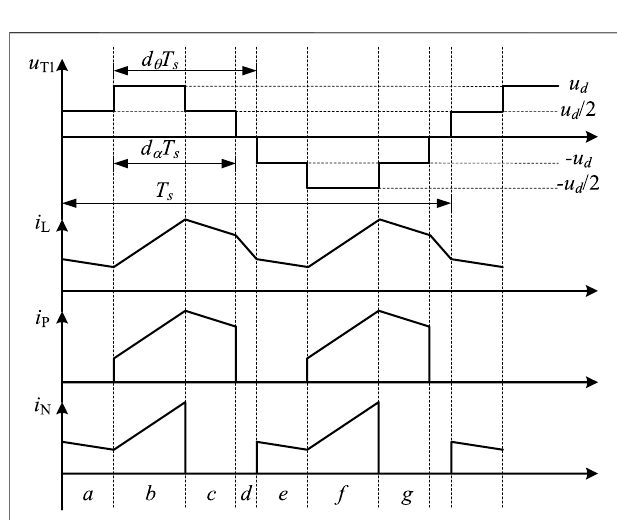
FIGURE 4 | Working waveforms of three-level H-bridge with phase-shift control.